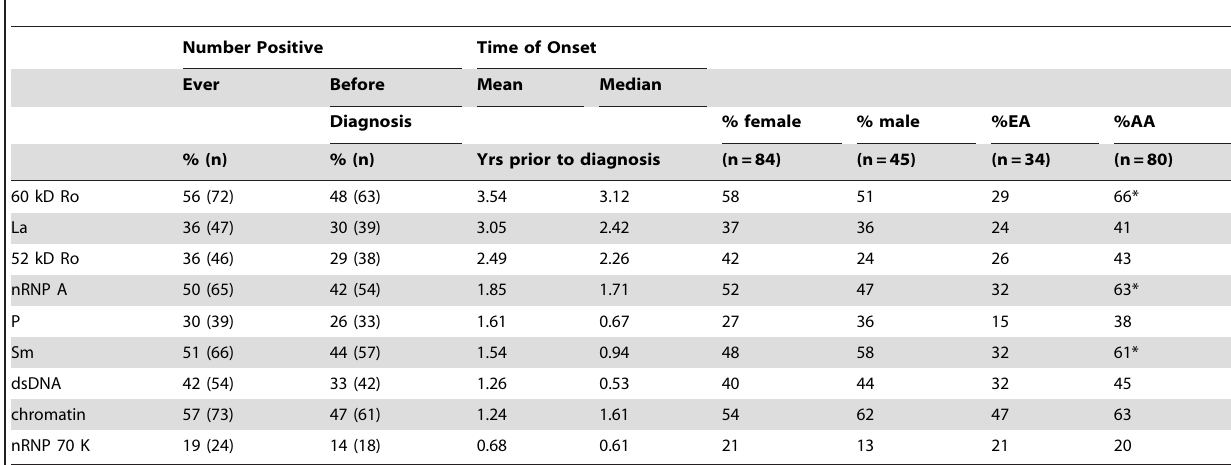
Table 1. Prevalence and time of onset of autoantibodies as detected by the BioPlex 2200 ANA Screen kit and demographics of patients positive for each